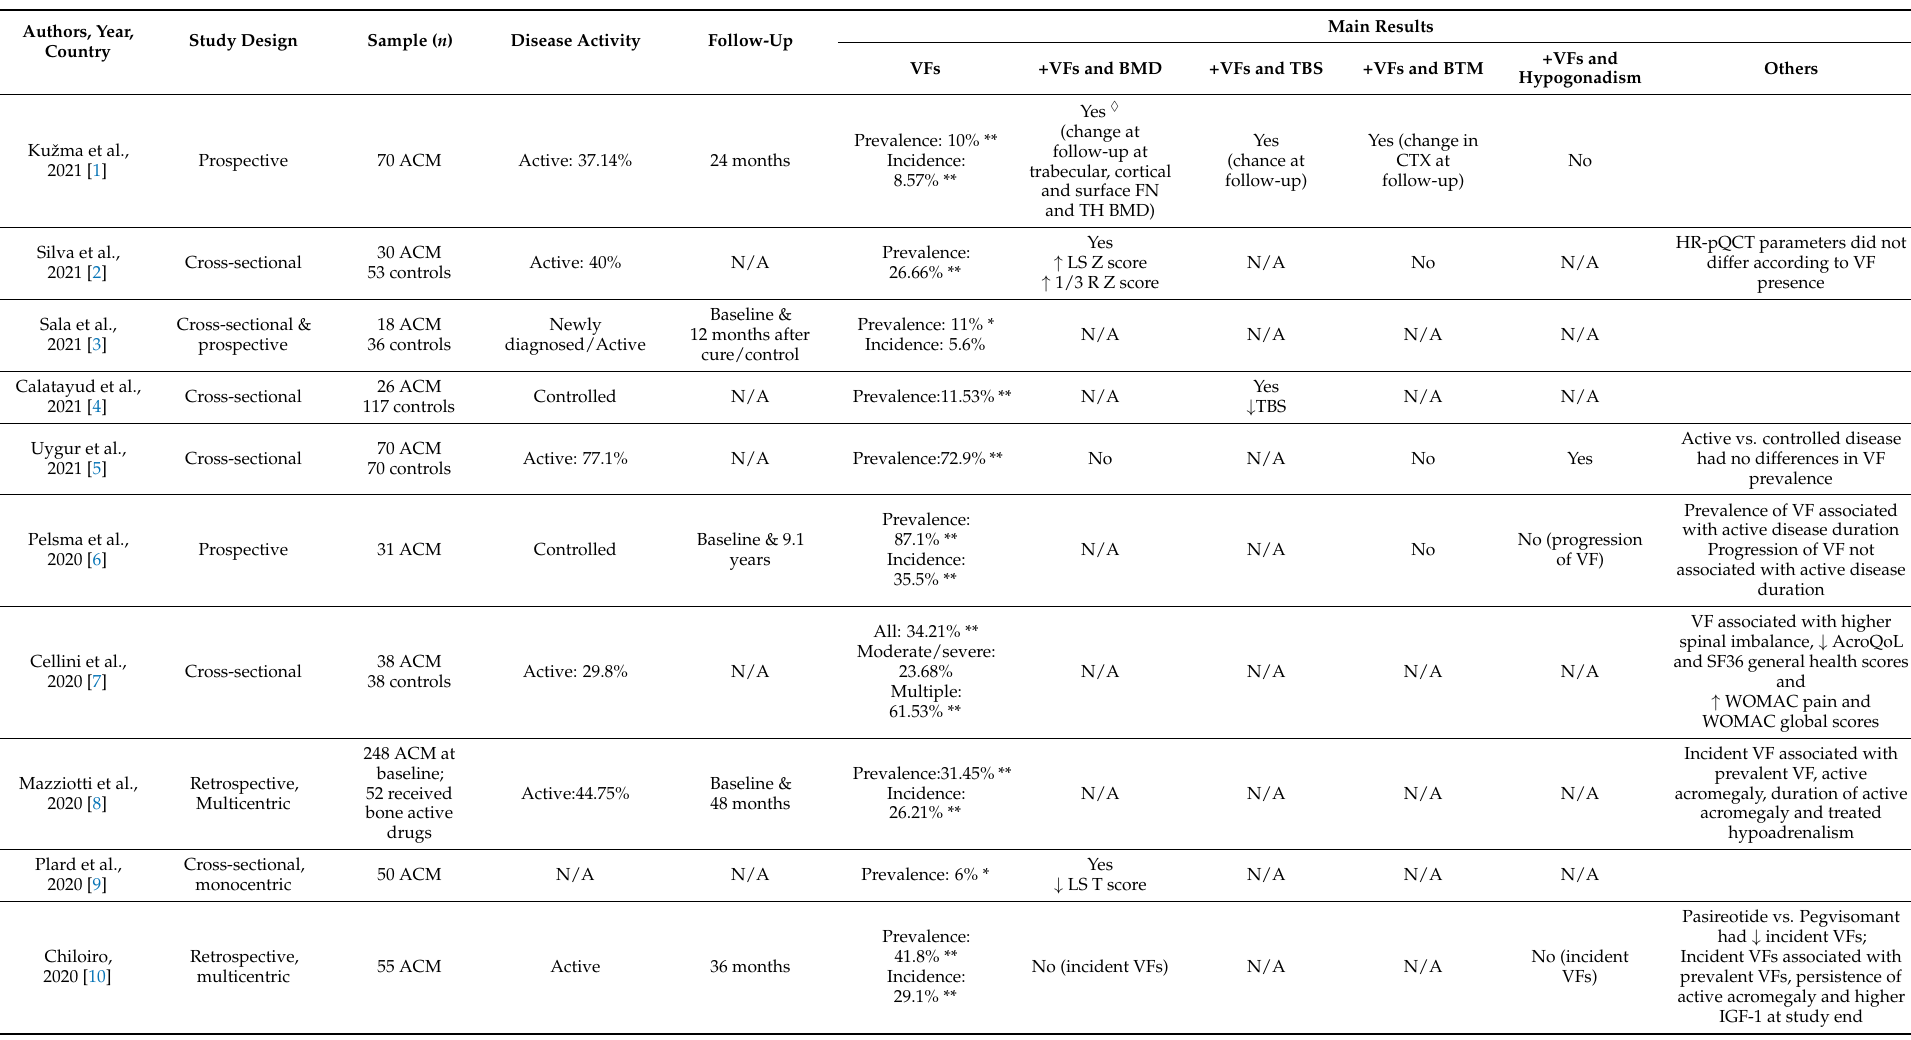
Table 1. Summary of studies assessing vertebral fractures in acromegaly